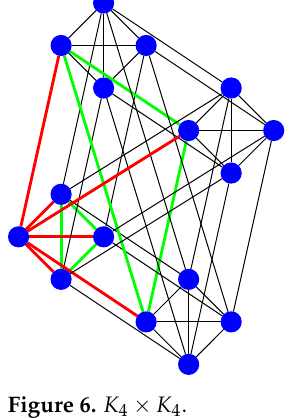
Figure 6. K 4 × K 4